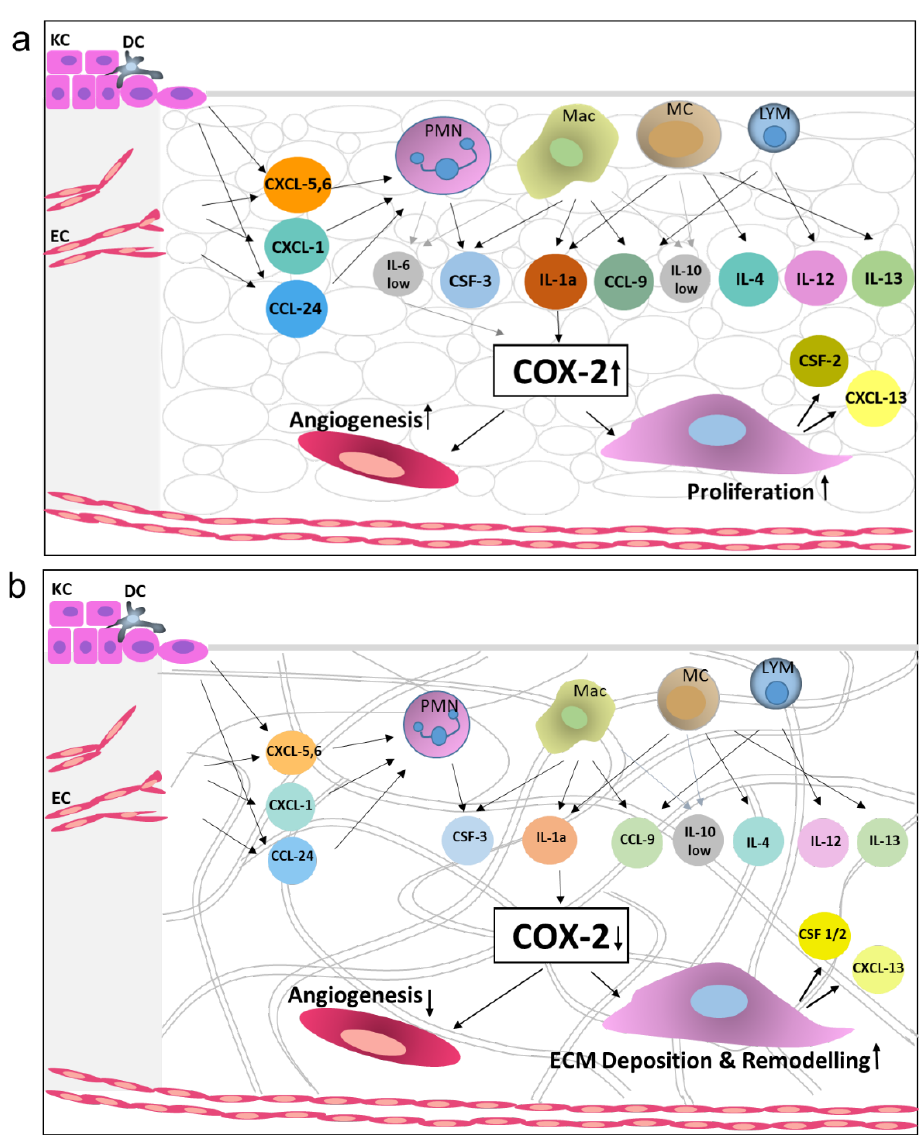
Figure 6. A schematic diagram representing the key differences between Integra, BTM and allogenic native skin grafts in terms of inflammatory and wound healing mediators’ expression levels. Growth factors showing differential expression at protein levels in grafts and cell types known to secrete these growth factors are presented. ( a ) Allogenic native skin graft (and to a lesser degree BTM graft) triggers significantly higher inflammation response in the host, compared to ( b ) Integra® , resulting in greater fibroblast growth and vascularisation. Integra® grafts, however, are more progressed towards ECM remodelling phase within this time point, possibly triggered by an excessive amount of collagen in the graft. The arrows suggest pathways, based on the literature below, which link the growth factors to the grafting outcomes. Only the feed-forward pathways (and no inhibitory pathways) are presented. Abbreviations: polymorphonuclear cells (PMN), macrophages (Mac), mast cells (MC), basal keratinocytes (KC), endothelial cells (EC), and dendritic cells (DC) [17,19,21–31].